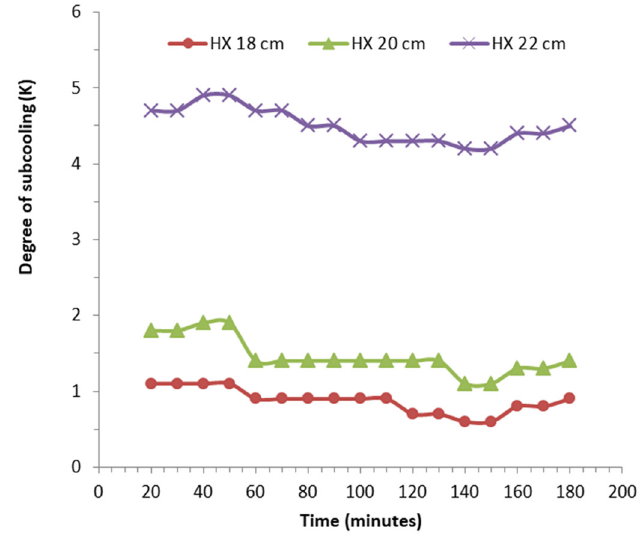
Figure 5. Degree of subcooling of air conditioner using condensate water as a subcooler for three different lengths of heat exchangers.